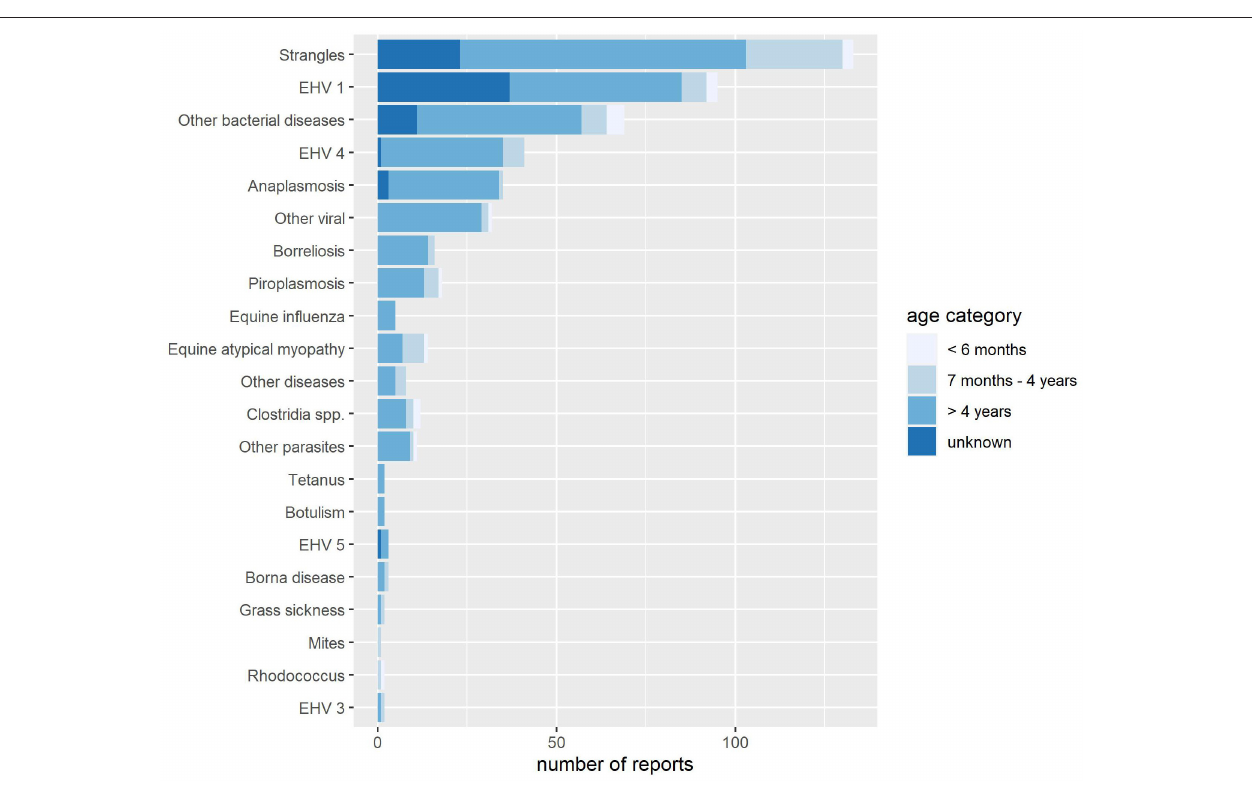
FIGURE 4 | Count of diseases per age category reported to Equinella between November 23, 2013, and April 26, 2019.